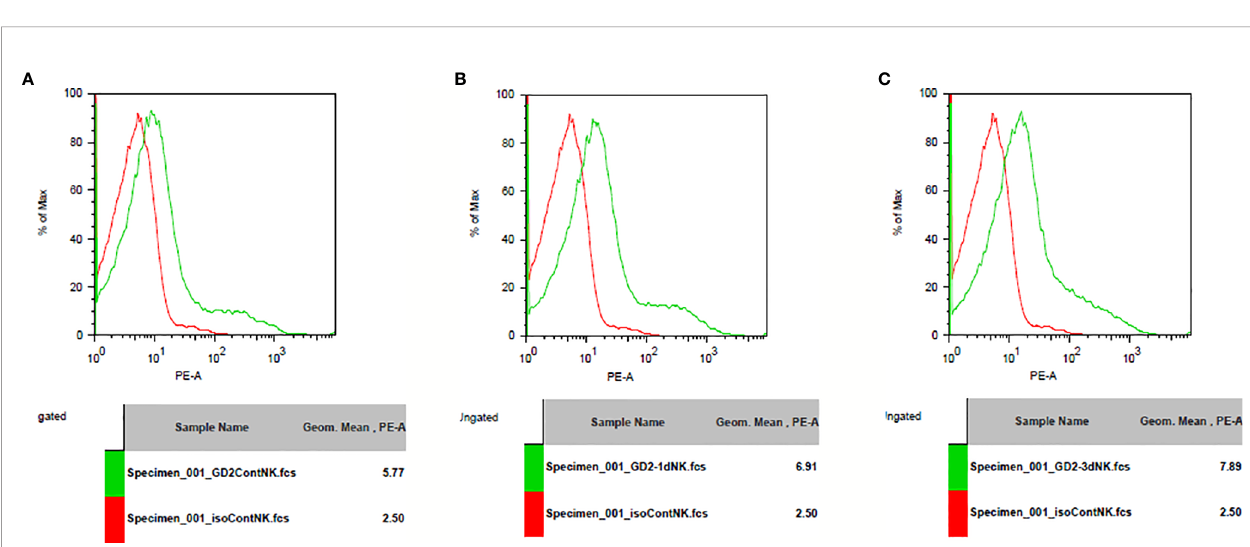
FIGURE 8 | GD2 antigen expression on spleenocytes of mice. (A) GD2 antigen expression on spleenocytes from normal mice compared to isotype control. There was GD2 expression on spleenocytes of normal mice. (B) GD2 antigen expression on spleenocytes from mice injected with IL-10 for one day compared to isotype control. There was GD2 expression on spleenocytes of mice with one dose of IL-10. The magnitude of GD2 expression of one-dose IL-10 injected mice is greater than that of normal mice. (C) GD2 antigen expression on spleenocytes from mice injected with IL-10 for three days compared to isotype control. There was GD2 expression on spleenocytes of mice with three doses of IL-10. The magnitude of GD2 expression of three-dose IL-10 injected mice is greater than that of normal mice and greater than that of one-dose IL-10 injected mice. cancer. The IL-10 receptor is only expressed on hematopoietic cells, including T cells, B cells, NK cells, mast cells, dendritic cells, and monocyte/macrophages, while Fc receptors are usually